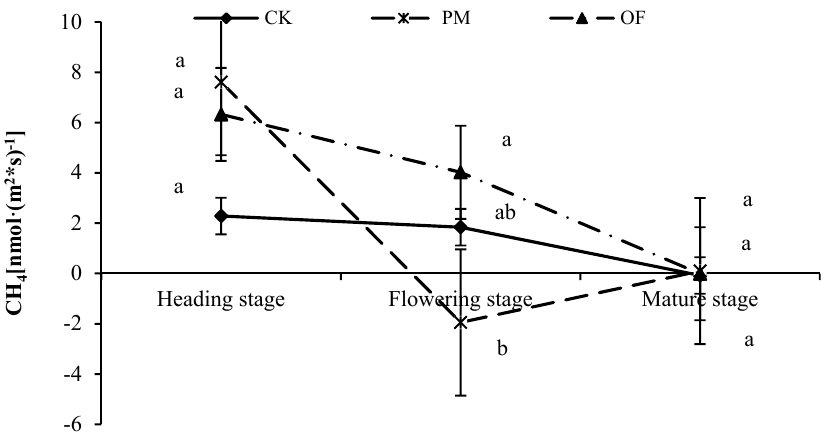
Figure 5. The effect of manure application on CH 4 emission from paddy field soil. Different lowercase letters indicate significant differences between groups ( p < 0.05).